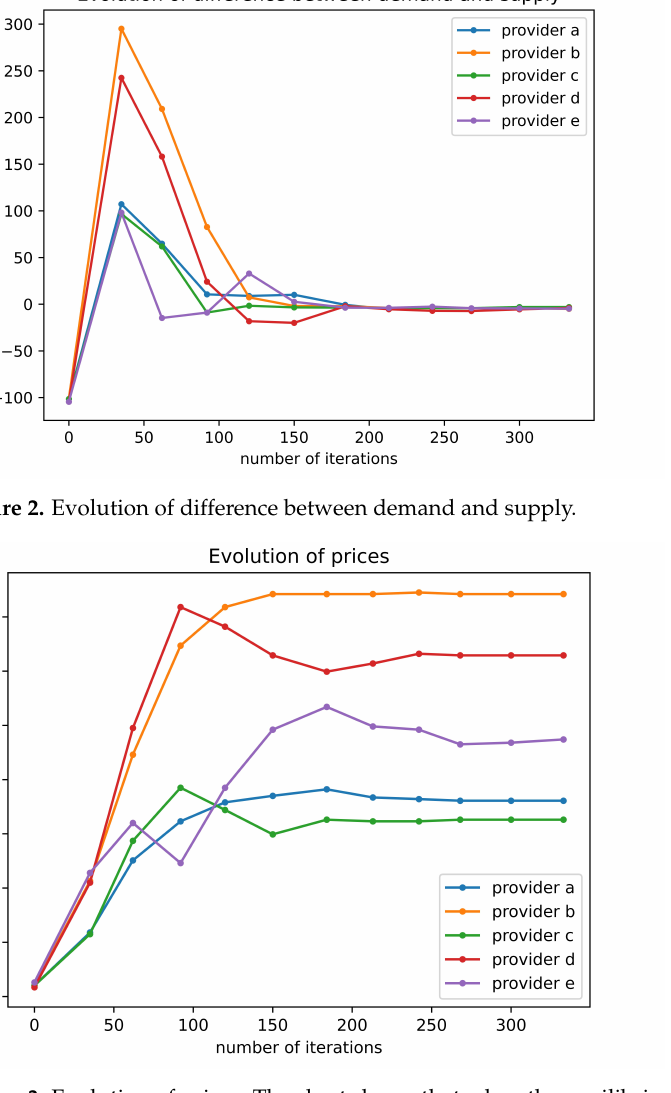
Figure 3. Evolution of prices. The chart shows that when the equilibrium state is reached, the price of supplier d is approximately 1.5 times higher than that of supplier a